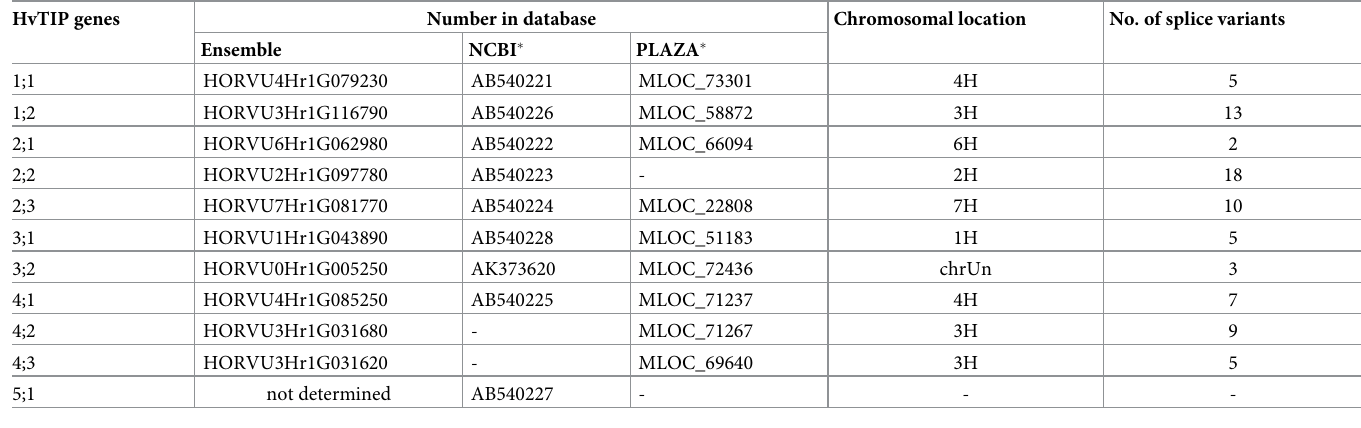
Table 1. Characteristics of HvTIP